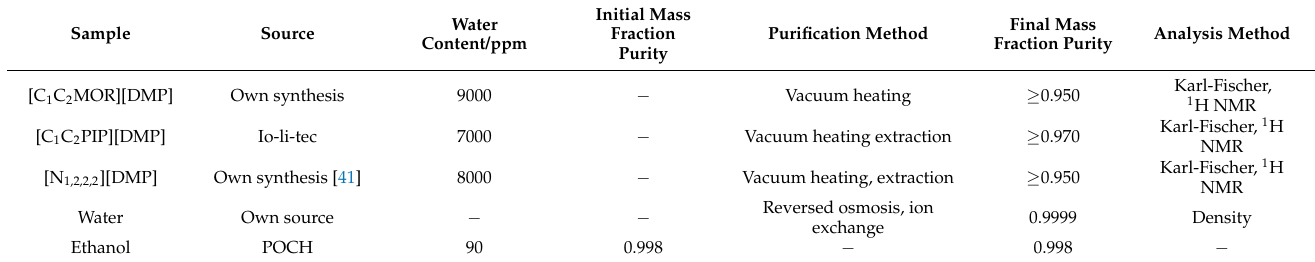
Table 14. Specifications of chemical